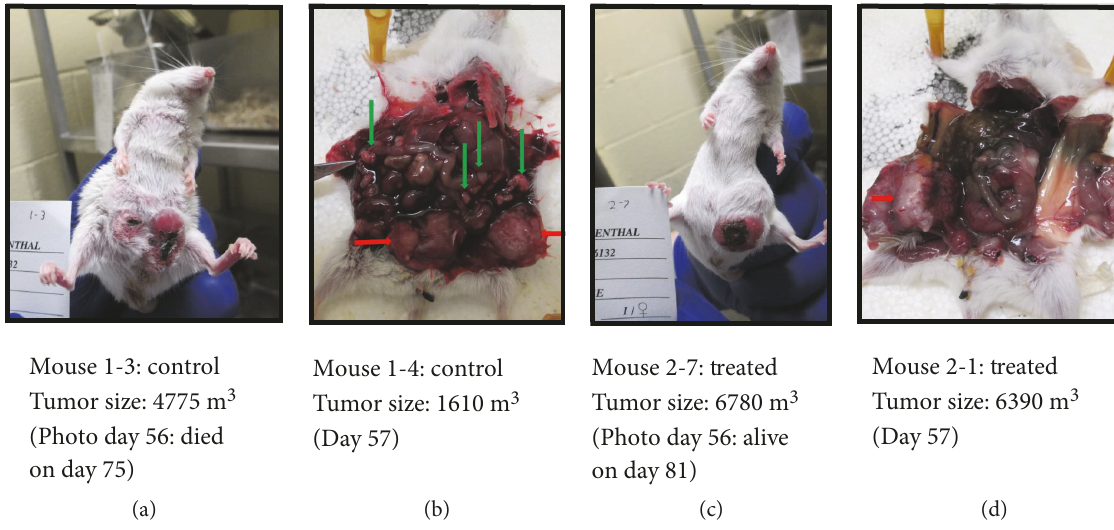
Figure 5: Appearance of representative mice from the J-HER treatment trial described in Figure 4. TUBO cell tumor development is shown for di ff erent control and J-HER-immunized mice. (a) Control, day 56, tumor size: 4775m 3 , died on day 75. (b) Control, day 57, tumor size: 1610m 3 . (c) Treated, day 56, tumor size: 6780 m 3 , survived the trial. (d) Treated, day 57, tumor size: 6390 m 3 . Red arrows indicate tumors at the site of implantation. Green arrows represent nodular tumors that spread within the